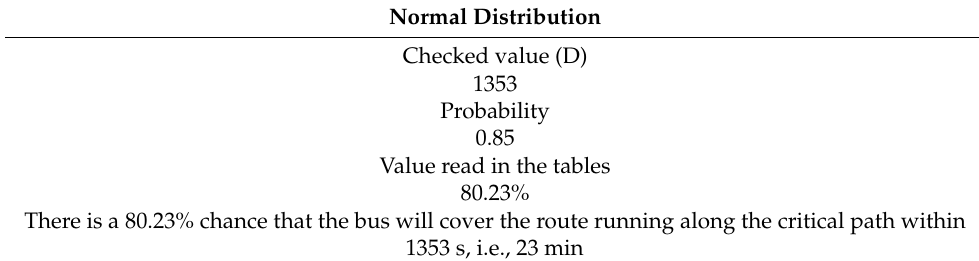
Table 6. Probability of covering the current bus line route in scheduled